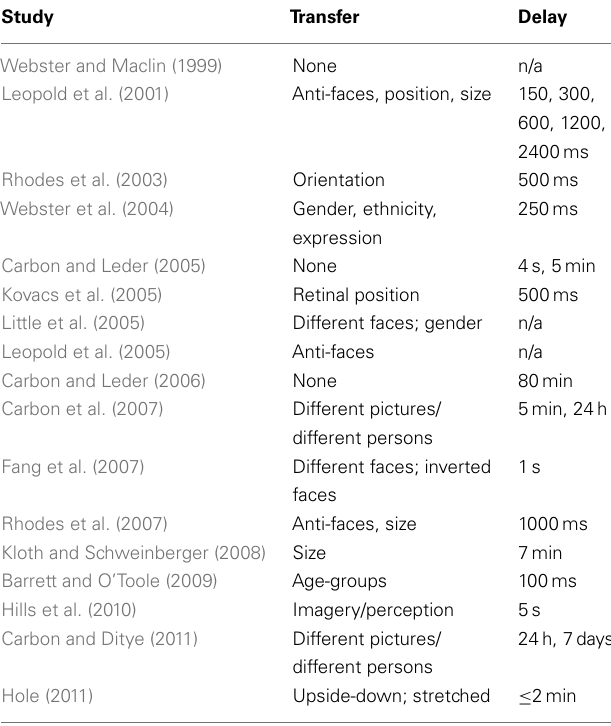
Overview of a selection of lab-based empirical studies on face adaptation in chronologicalordersystematizingthetransferconditionsbetweenadaptationand